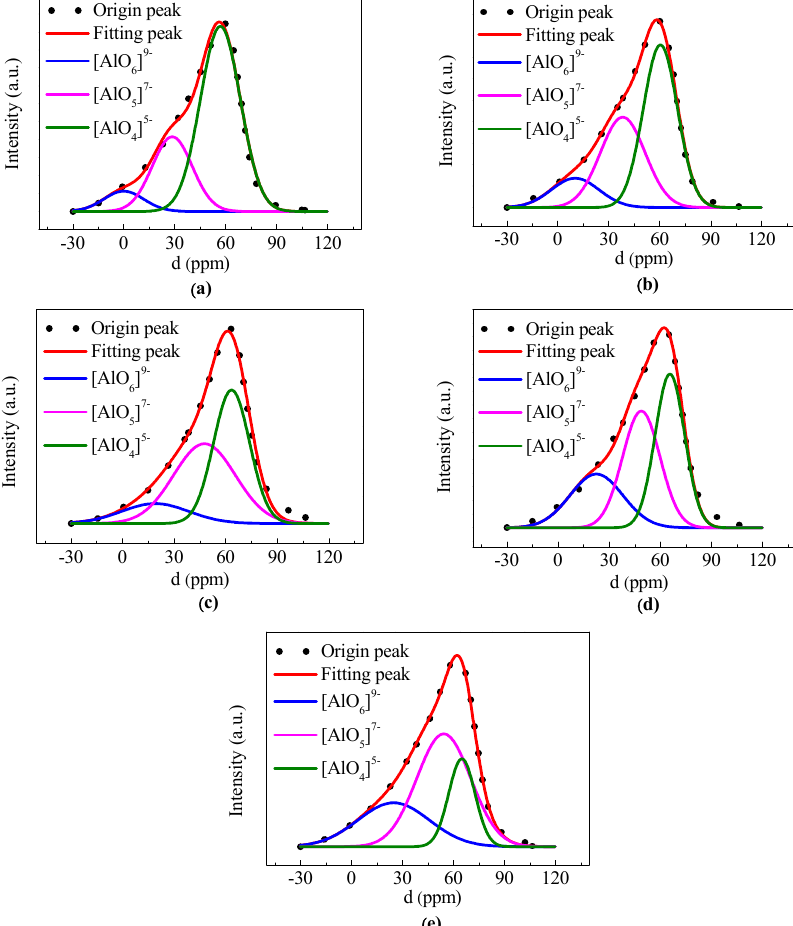
Figure 10. Deconvolution results of the 27 Al-SS-MAS-NMR curves with various R 2 , and ( a ) the R 2 is 0.9, ( b ) the R 2 is 1.0, ( c ) the R 2 is 1.1, ( d ) the R 2 is 1.2, ( e ) the R 2 is 1.3.